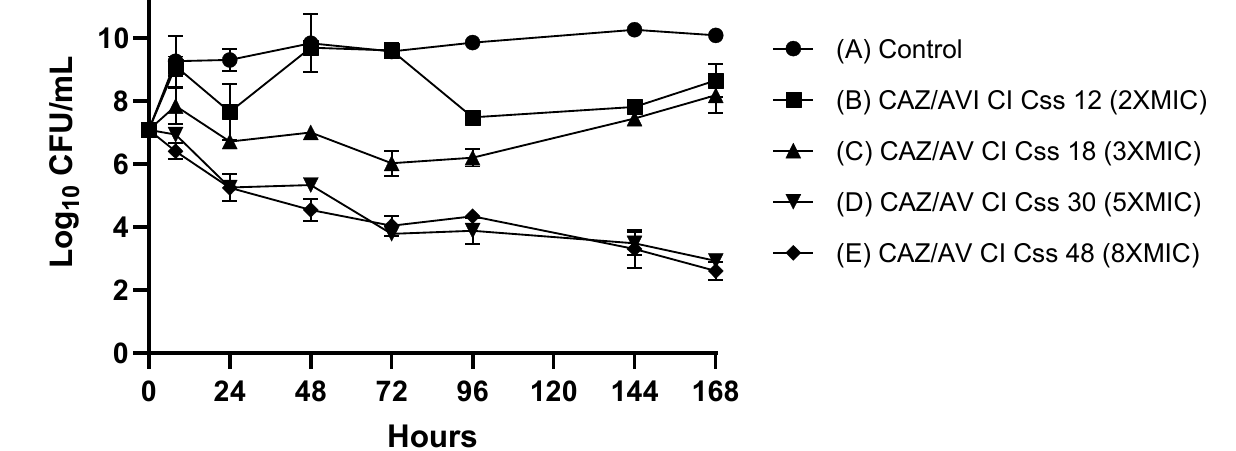
Figure 1. Mean reduction in bacterial density during 7-day HFIM assays (in duplicate) with the XDR P. aeruginosa index isolate treated with different Css of CAZ-AVI (12, 18, 30 and 48 mg/L) in CI. CFU, colony-forming unit; CI, continuous infusion; Css, steady-state concentration; MIC, minimum in- hibitory concentrations. Errors bars are expressed as standard deviations (SD).